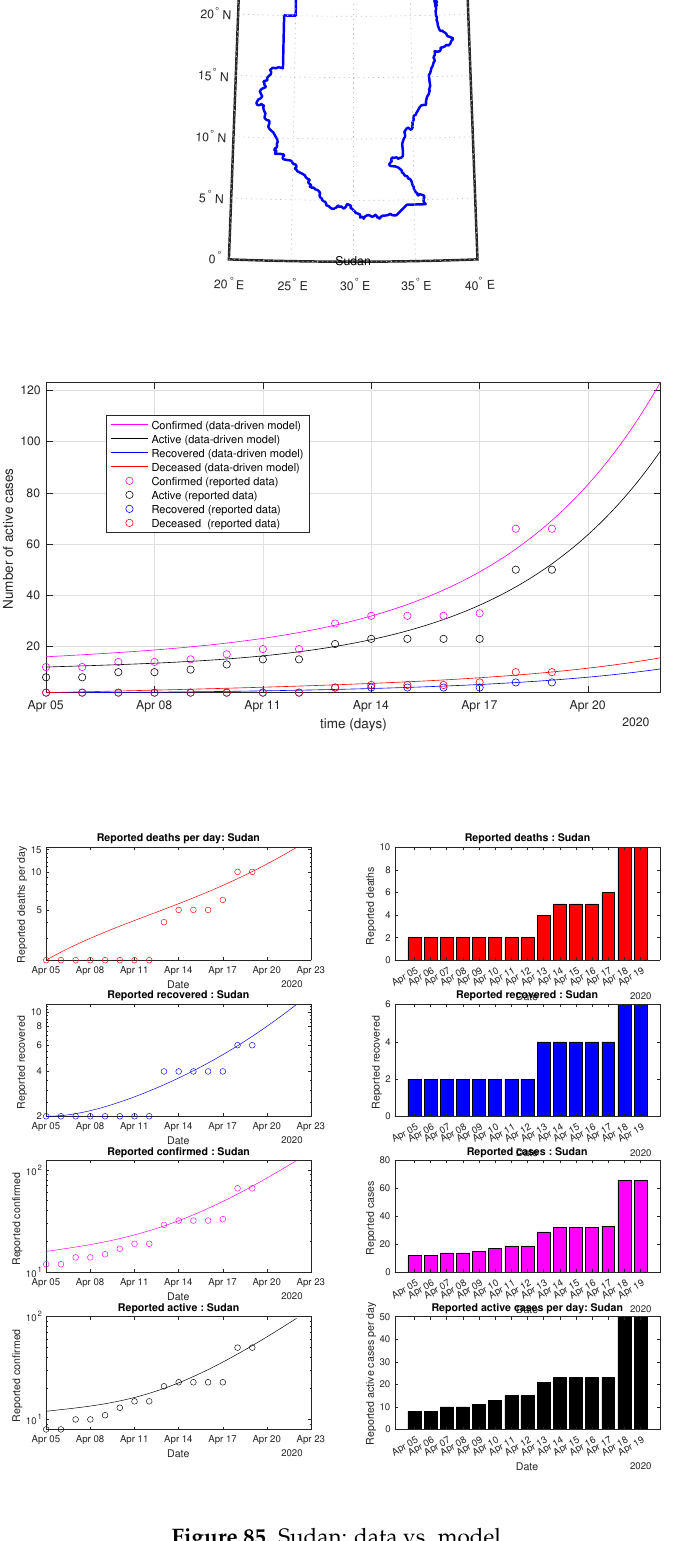
Figure 85. Sudan: data vs.